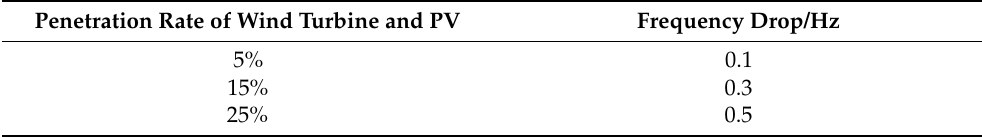
Table 2. Frequency drop caused by different penetration rates of wind turbine and